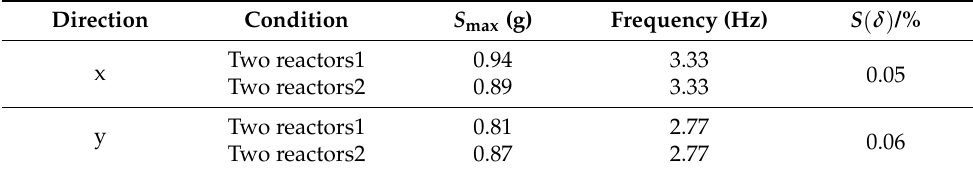
Table 4. Comparison of FRS at different locations of raft foundation.